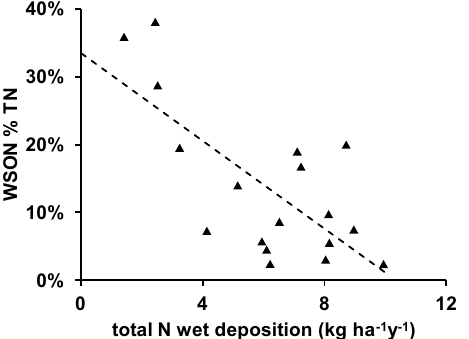
Fig. 2. Relationship between the proportion of total N represented by WSON, and the wet deposition of total N at each site, showing the strong inverse relationship.